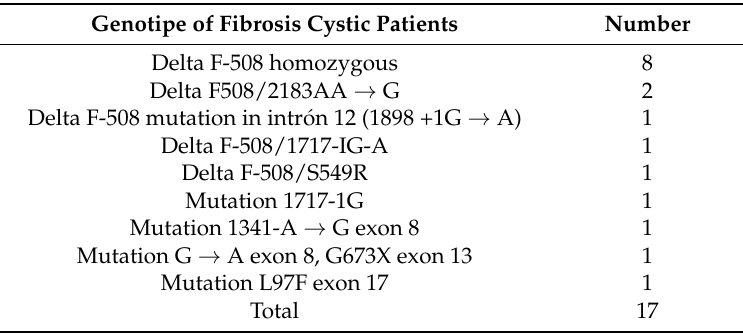
Table 2. Genotipe of fibrosis cystic patients.